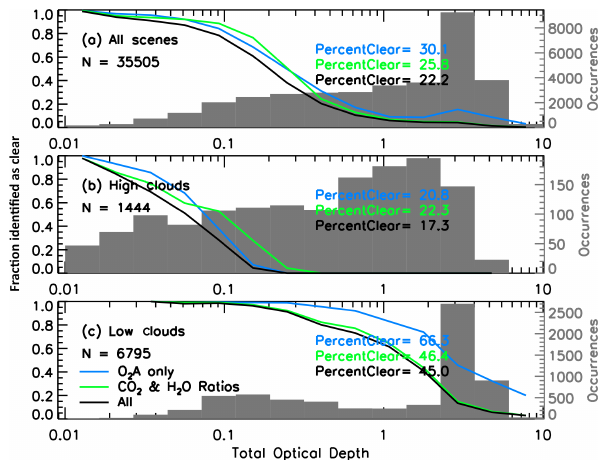
Figure 2. The fraction of simulated OCO-2 soundings identified as clear by the ABP screen alone (blue), by the R CO (green) and by all three filters combined (black), plotted as a func- tion of the total cloud plus aerosol optical depth (TOD) at 760nm. The frequency histogram of the TOD is plotted in gray against the right ordinate. Panel (a) shows all cloud cases, while panel (b) shows only those scenes where 95% of the OD resides in the upper 40% of the atmosphere (i.e., high clouds) and panel (c) shows cases where 95% of the OD resides in the lowest 30% of the atmosphere (i.e., low clouds layers). Only the June nadir-land data are shown.